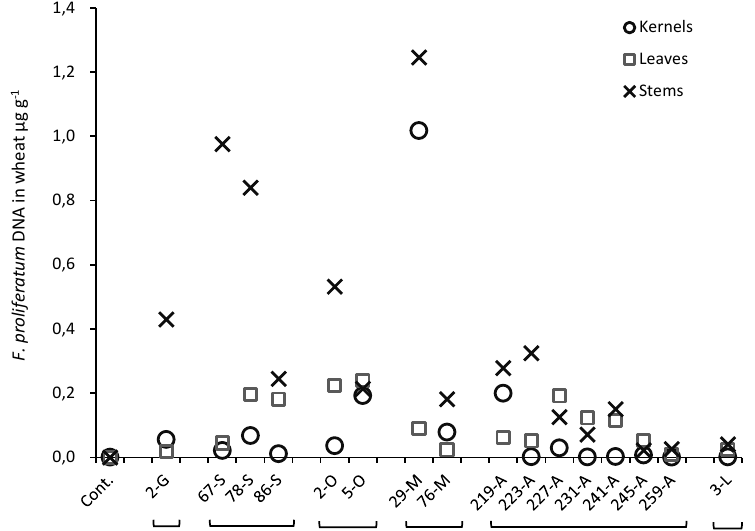
Fig. 2. Fungal DNA of F. proliferatum strains in wheat stems (the internode between the last node and ear), the first flag leaves, and kernels was quantified by real